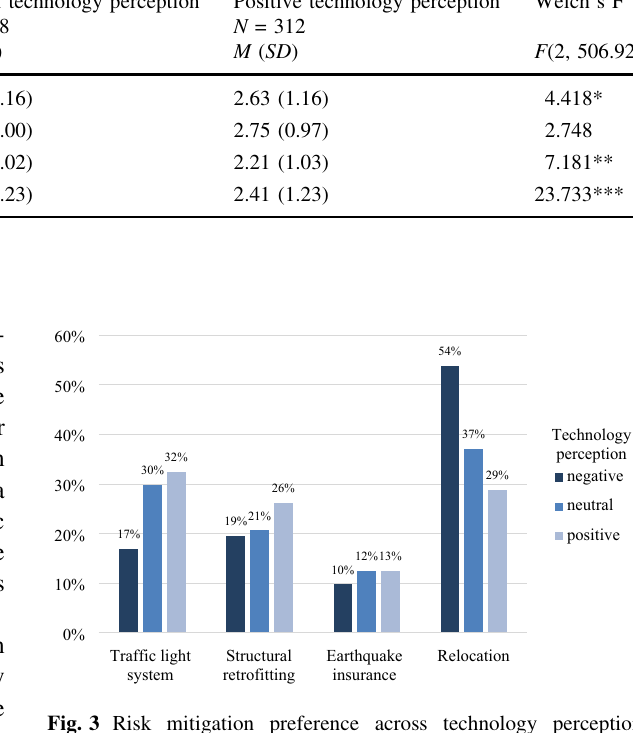
Table 4 Preference of risk mitigation measures by technology perception ( N = 807) Measures